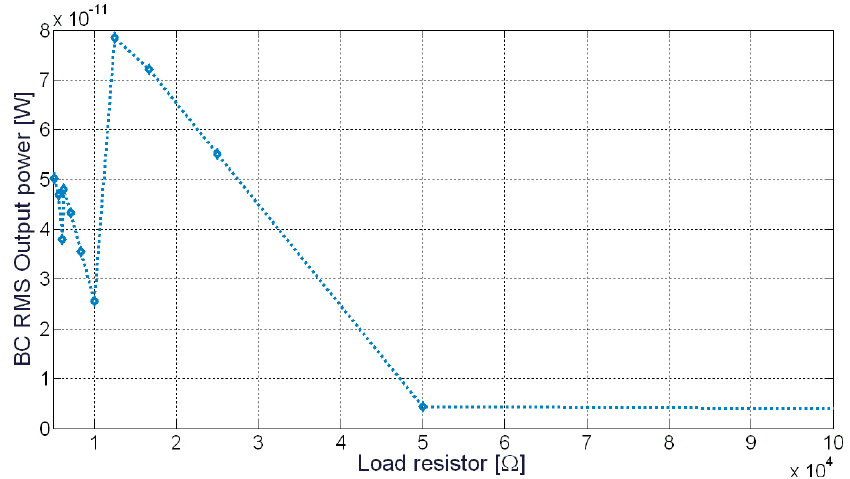
Figure 10. The BC output power as a function the resistive load value.